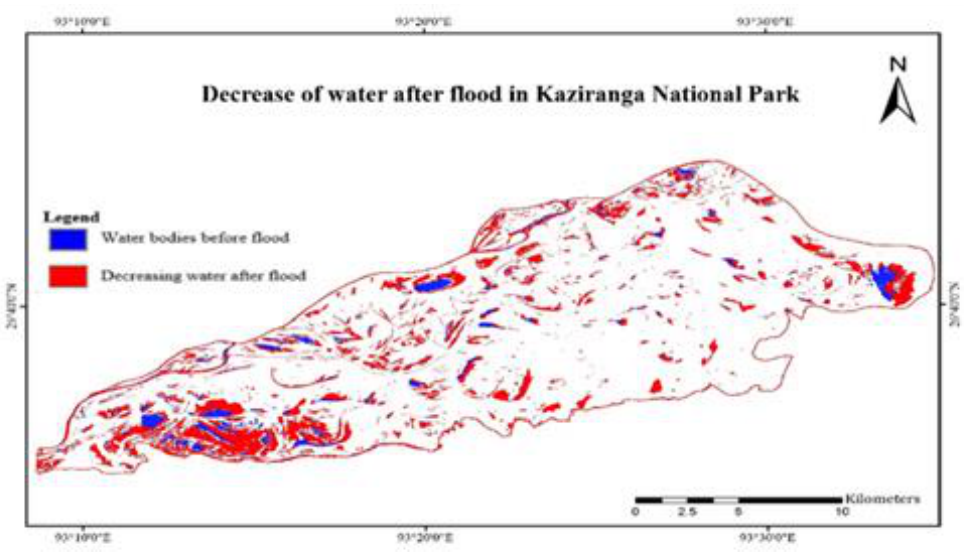
Figure 9. The decrease of water flood in Kaziranga National